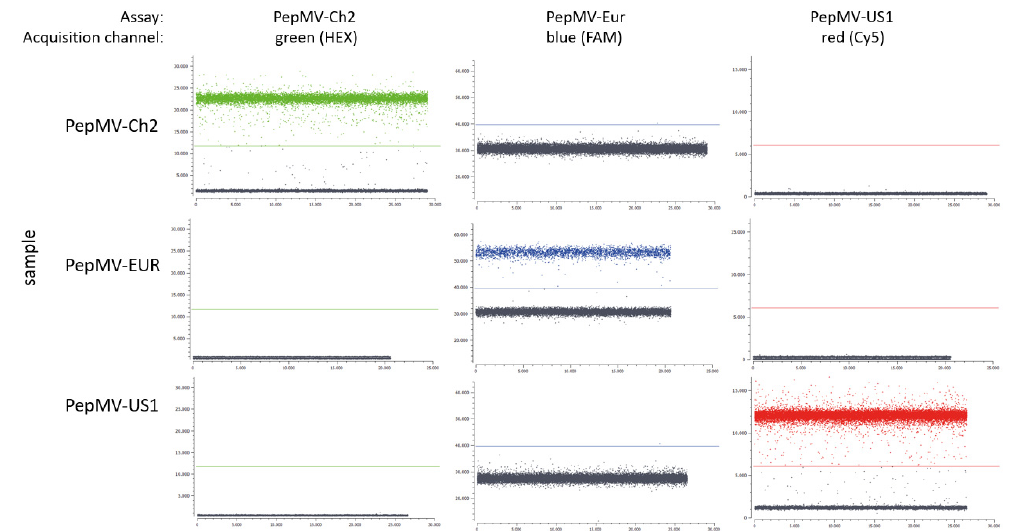
Figure 2. Specificity of RT-dPCR assays tested on the Naica platform. Specificity was confirmed by testing di ff erent PepMV genotyping assays on samples containing di ff erent PepMV genotypes. RNA isolated from leaves of infected test plants with PepMV-Ch2 (dilution, 10 − 4 ), PepMV-Eur (dilution, 10 − 4 ) and PepMV-US1 (dilution, 10 − 5 ) were tested. For each sample, the plot representing droplet fluorescence intensity in the green / blue / red acquisition channel on the y axis, and droplet index (a number assigned to each droplet during analysis) on the x axis. The setting of the threshold for the droplet positivity was done automatically by the Crystal Miner software, and is shown by the horizontal lines. As the results did not di ff er between the technical repeats, the representative results of one of the technical repeats are shown. Table 2. Reproducibility of the RT-dPCR assays for PepMV RNA.